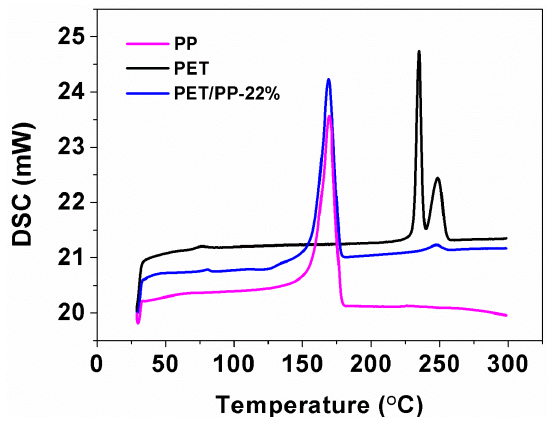
Figure 7. DSC curves of the PP separator, the PET/PP-22% and PET granular materials.